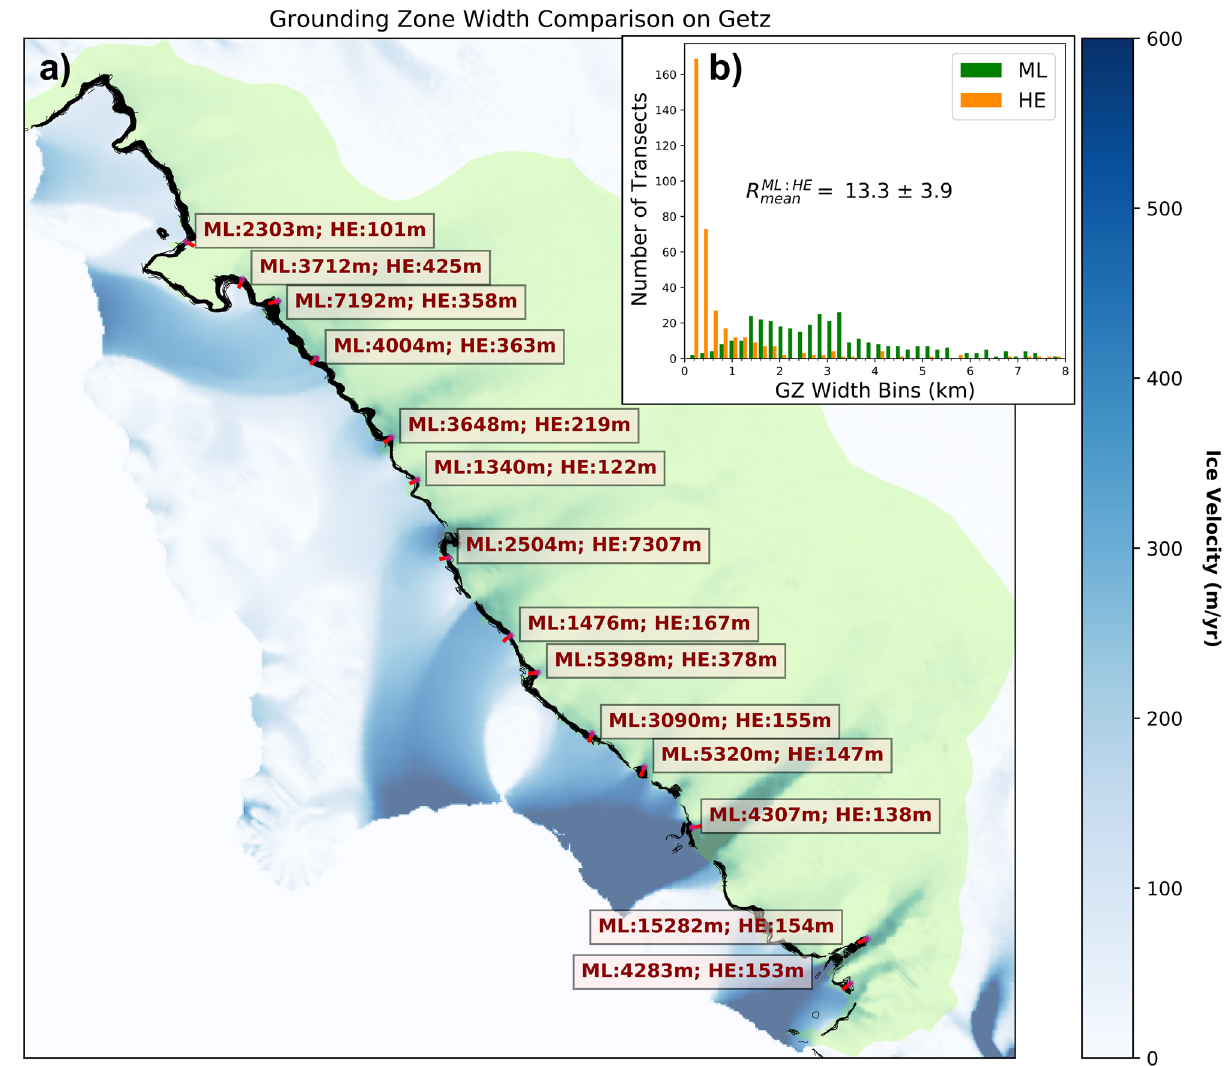
Figure 5. Comparison of the predicted width of the grounding zone from hydrostatic equilibrium (HE) versus the observed width from machine learning (ML) along Getz Ice Shelf, West Antarctica. ( a ) Sample 14 comparison sites along the coast. Getz Basin is green shading. Ice speed 24 is color-coded in blue. The 2018 grounding lines are black. The delineated ( ML ) and expected ( HE ) widths are quoted in red letters along the flow direction (red line). ( b ) HE vs. ML GZ width less than 8 km for 500 transects along the coast. R mean ratio of ML to HE width. The ice speed field is obtained from the MEaSUREs data product 24–26 and plotted with Rasterio version 1.0.21 18 . The grounding lines, width labels, and the histogram in the inset are plotted with Matplotlib version 3.3.2 19 . The Getz basin is drawn according to the Rignot drainage basin divisions 1,27–30 and is plotted using Descartes version 1.1.0 37 and Matplotlib version 3.3.2 19 . All libraries are used with Python 3.7.4 17